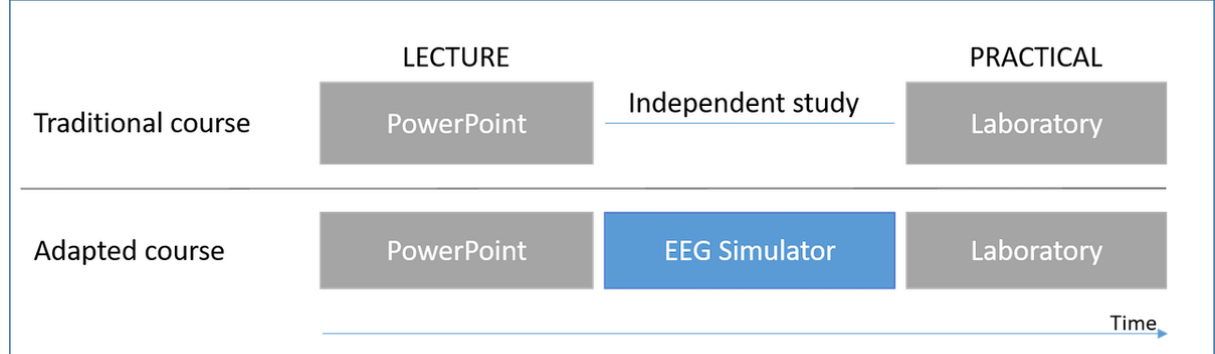
Figure 2. Traditional and adapted neurophysiology course. EEG: